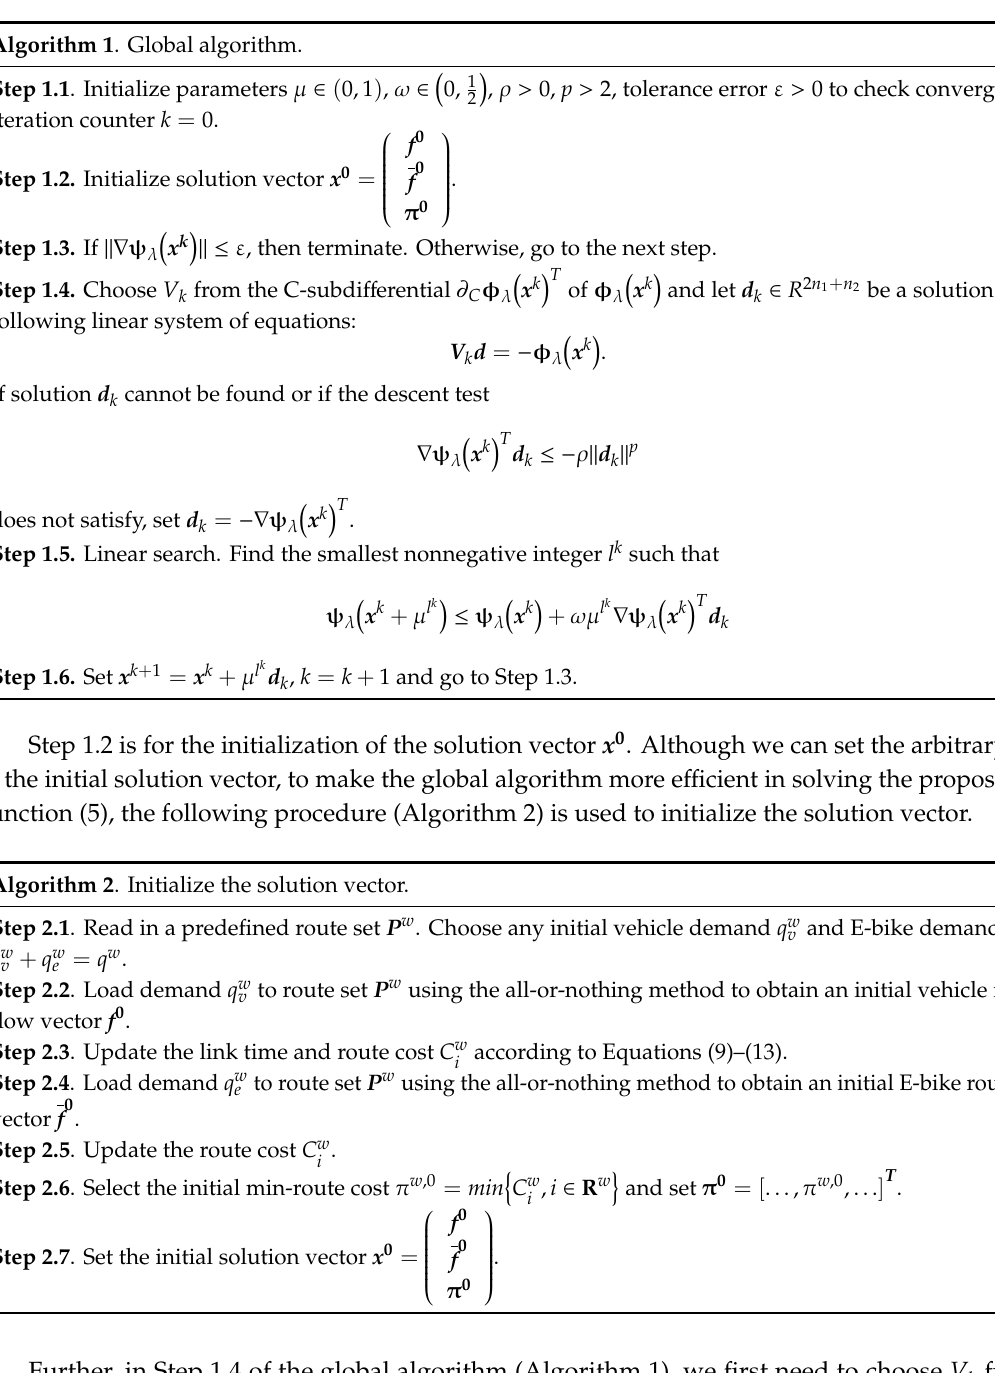
Algorithm 3 to choose V k